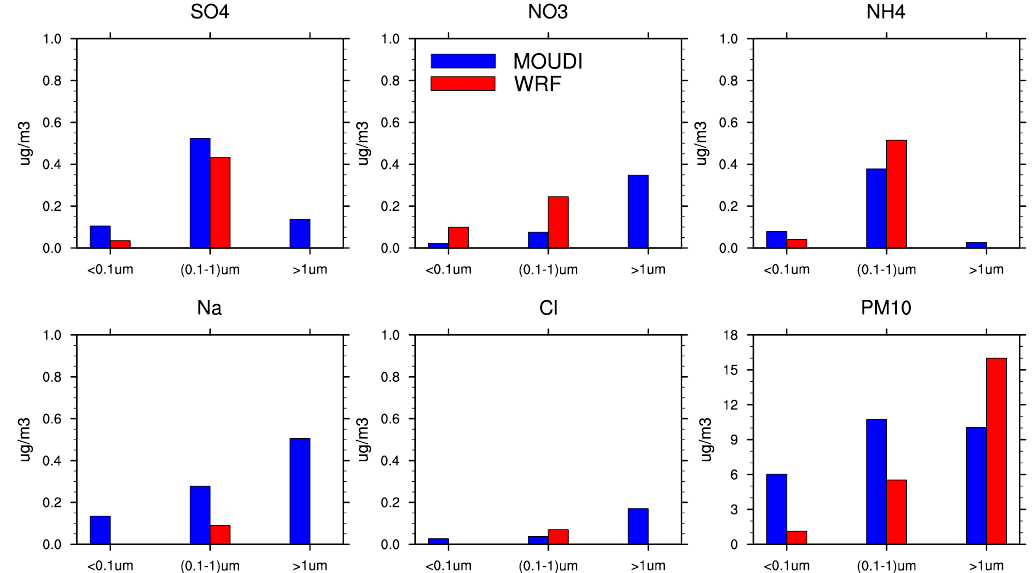
Figure 15. The observed and predicted average aerosol mass size distribution for SO 4 , NO 3 , NH 4 , Na, Cl, and other PM 10 constituents at IAG-USP. The observed aerosol distributions were collected in 10 size classes using a rotated impactor (MOUDI) and joined adequately according to the three modes used by the MADE aerosol scheme: Aitken (<0.1µm), accumulation (0.1–1µm), and coarse (>1µm). The five inorganic ions carried in MADE are only calculated for the Aitken and accumulation modes. The WRF’s PM 10 aerosol variable does not include neither OC nor EC for this